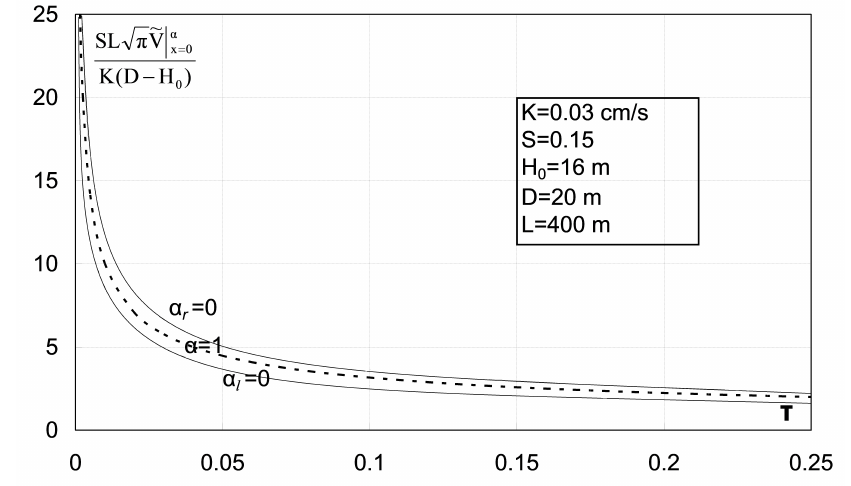
α V versus dimensionless time τ α V x = 0 x = 0 versus dimensionless time (cid:12) (cid:12) (cid:12) (cid:101) (cid:12) e